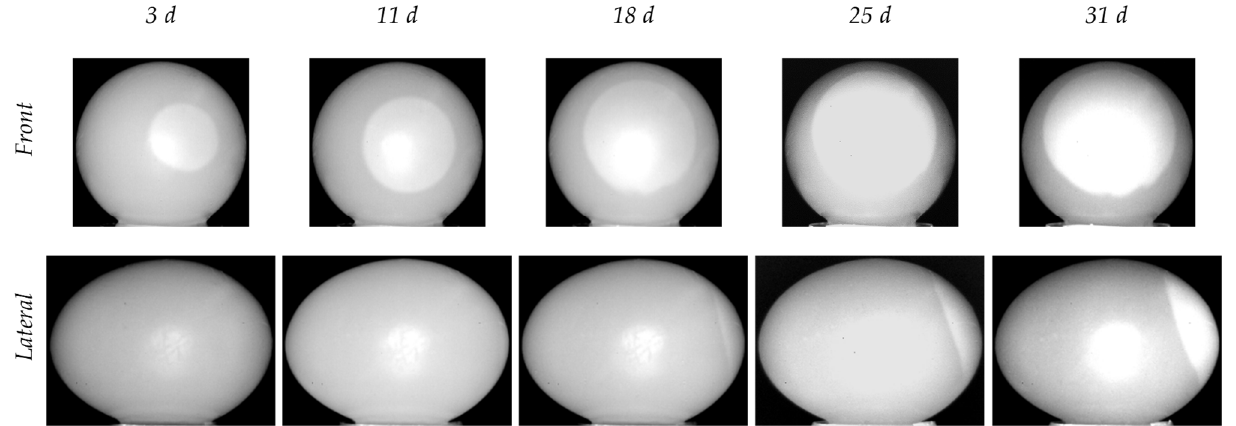
Figure 4. Grayscale raw IR images of egg XL#7 recorded on different days. First row: front view (dull pole). Second row: lateral view.